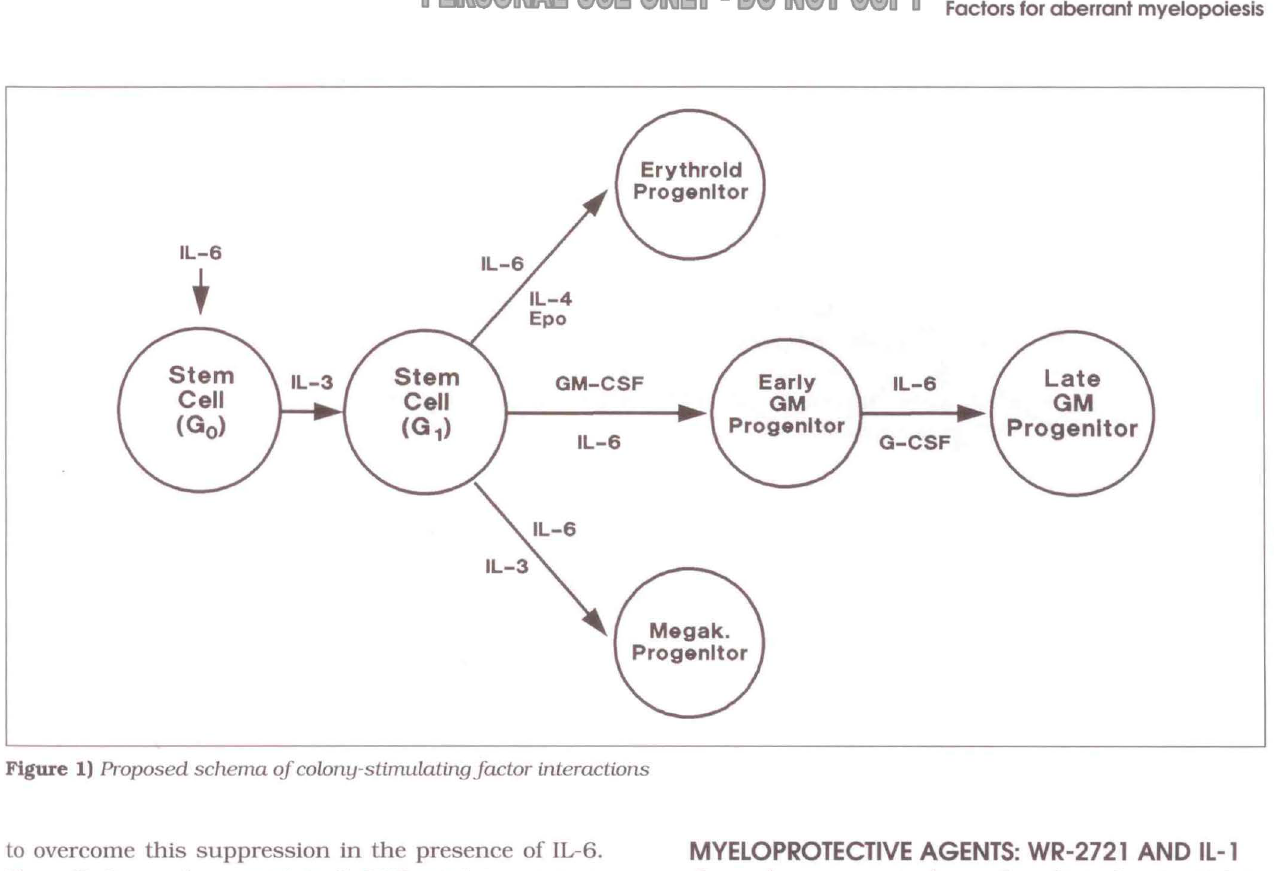
to overcome this suppression in the presence of